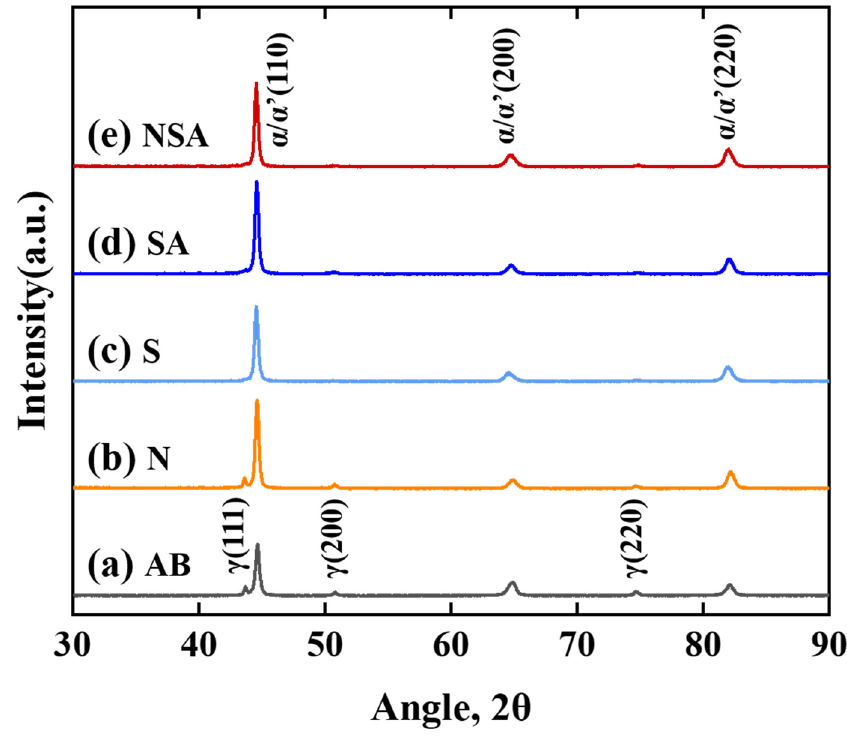
Figure 5. XRD patterns of the as-built and heat-treated 17-4 PH samples.